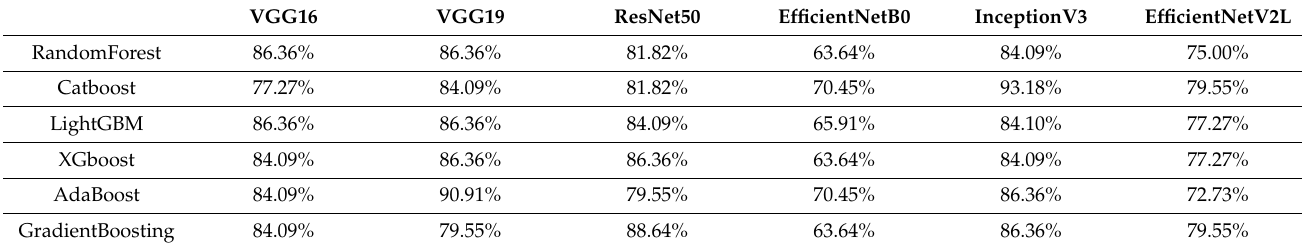
Table A3. Accuracy of each model combination for gray diamonds.